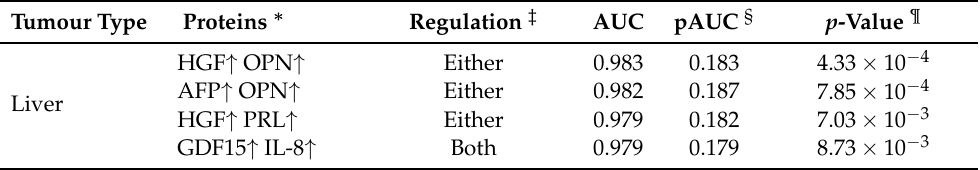
Table 2. Two-protein blood biomarkers for liver, ovarian, and pancreatic cancers. Details of the 26 cancer biomarkers that have AUC-values greater than the critical values in Table 1. Proteomic dataset from Ref. [28] and composite biomarkers are formed as per Ref. [31]. Up arrow, ↑ , the protein is up-regulated among donors who have cancer relative to the healthy controls. Down arrow, ↓ , the protein is down-regulated among cancers relative to controls. ‡ Whether it is necessary for positive classification that either or both of the proteins are up or down-regulated. § The pAUC-value is computed in the interval [ 0,0.2 ] . ¶ The p -value is Bonferroni corrected for simultaneous hypothesis testing of 53,352 biomarkers, under the null-hypothesis that each are on par with the colorectal cancer test FIT, which has AUC 0.88 ([32] p.